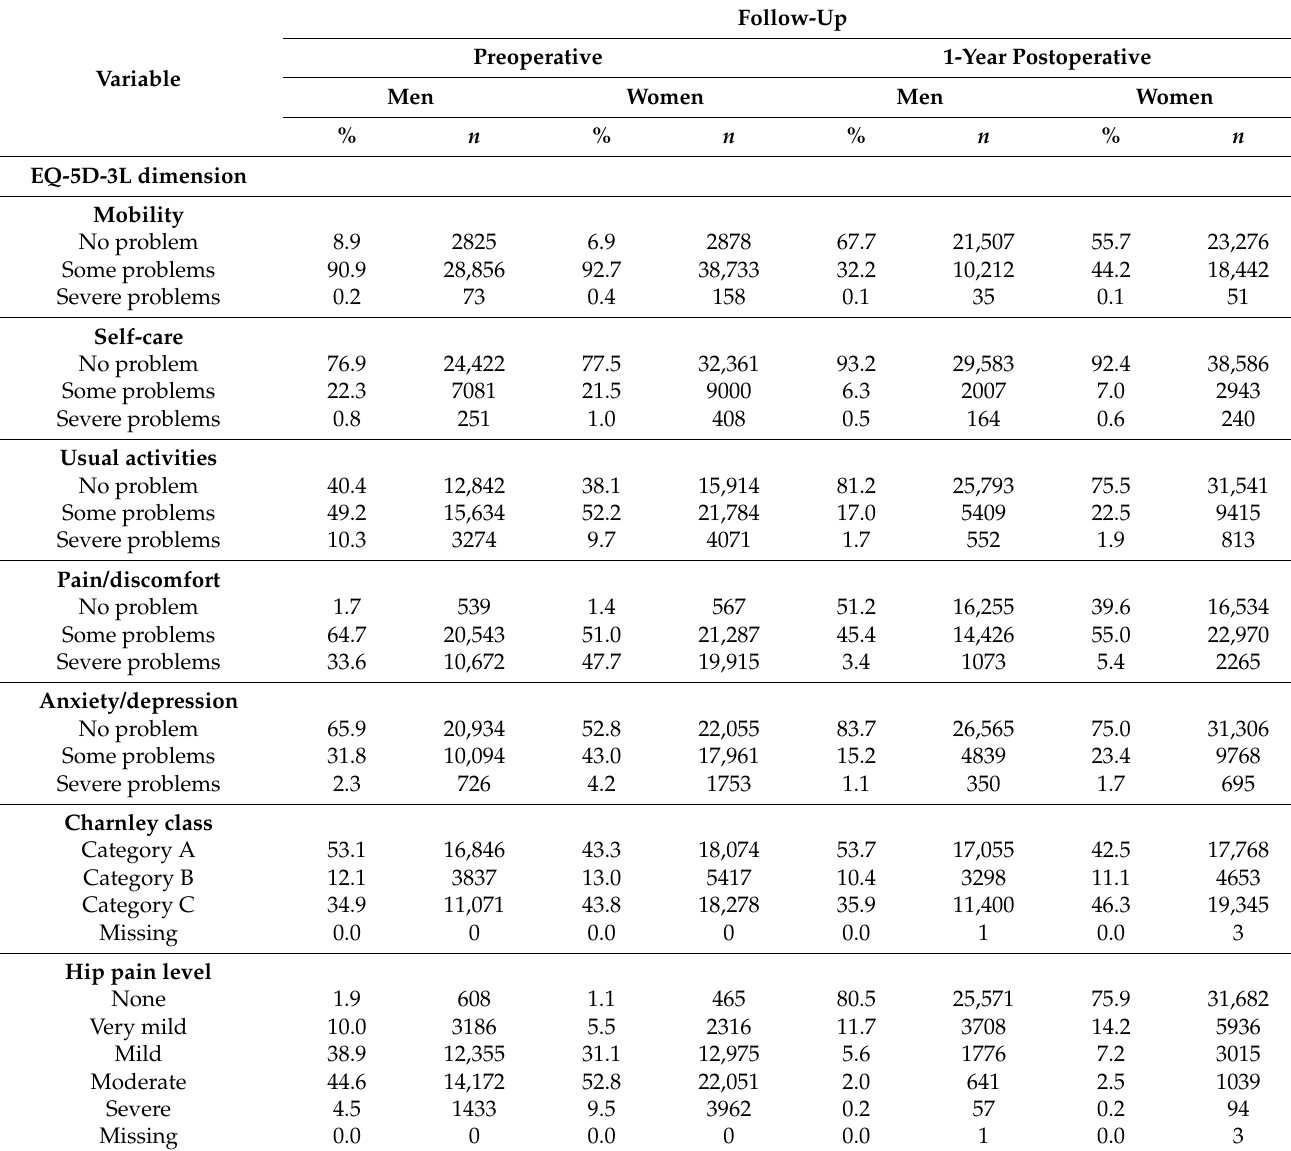
Table 1. Prevalence of reported problems in the EQ-5D-3L dimensions, Charnley classes, and hip pain level by sex pre- and 1 year postoperatively ( n =